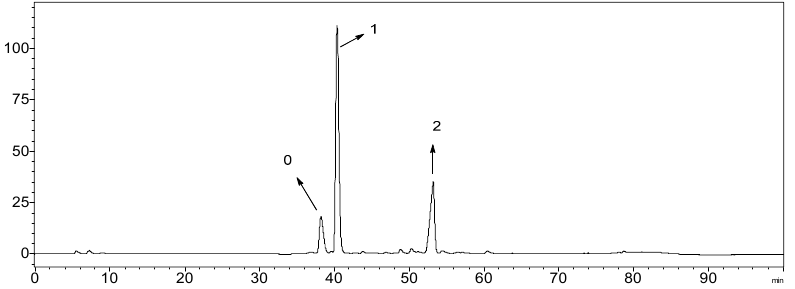
Figure 7. The PHPLC chromatogram of sample 1 (0: Notoginsenoside R 1 ; 1: Ginsenoside Rg1 and Re; 2: Ginsenoside Rb1).